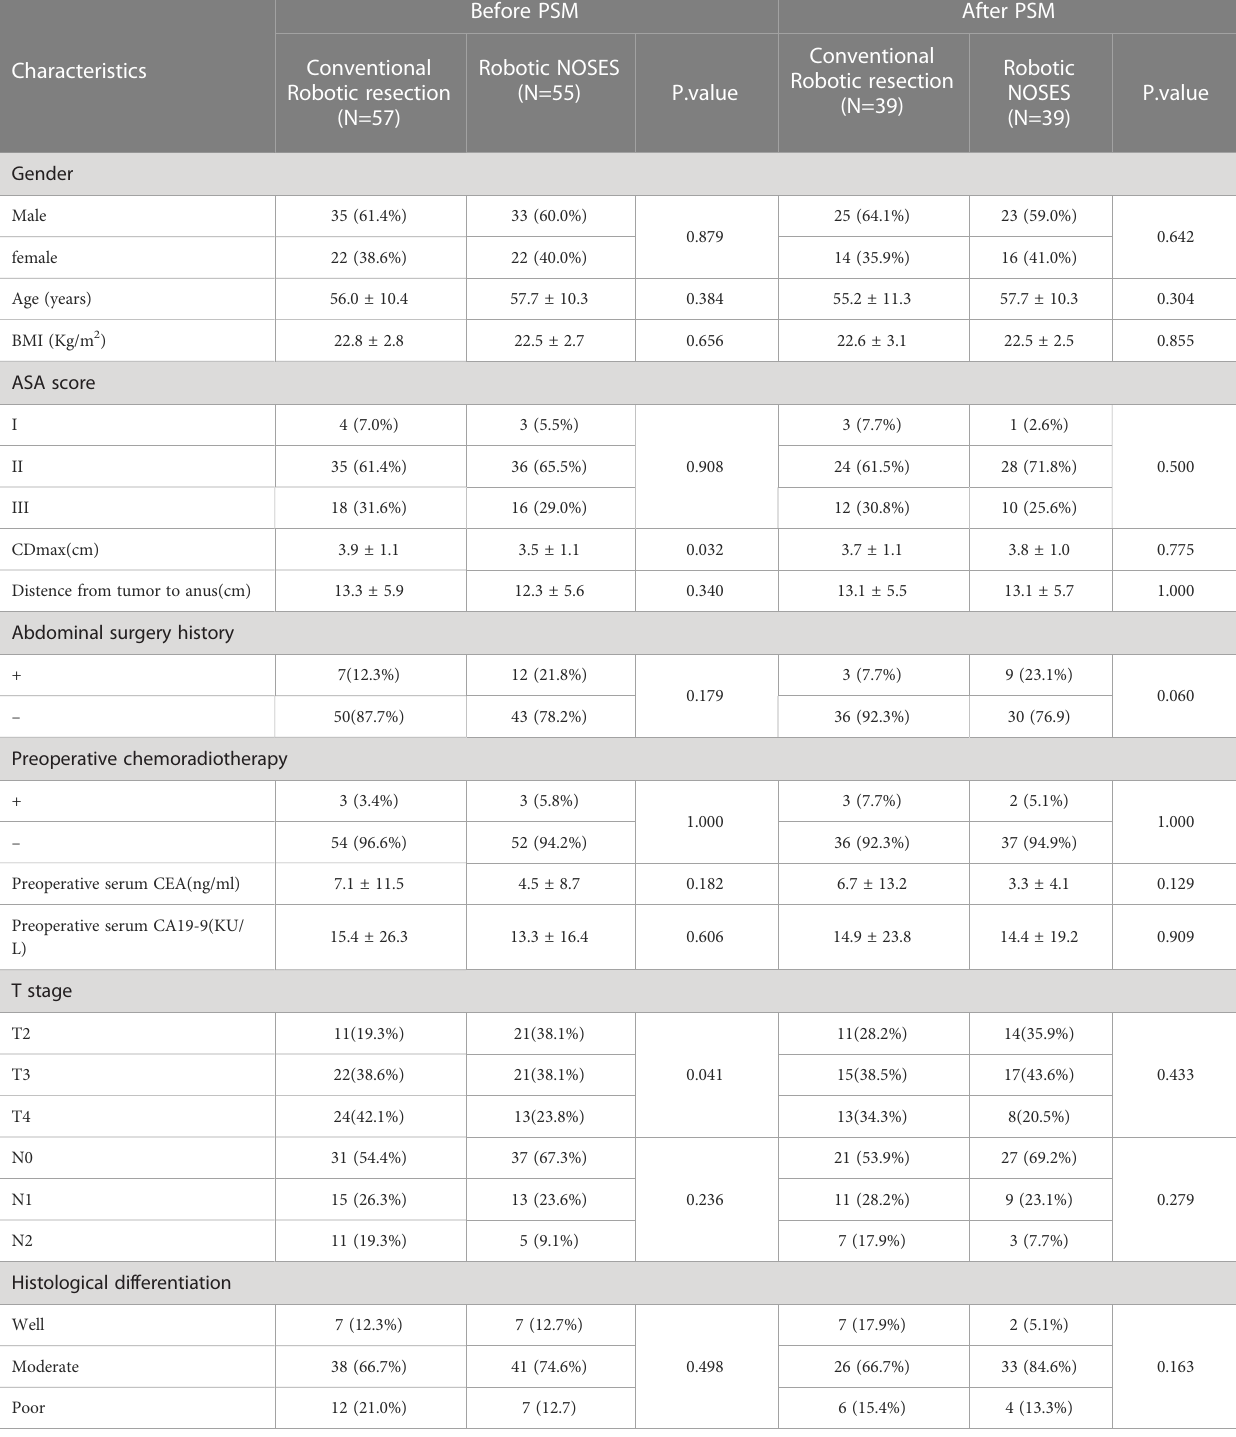
TABLE 1 Clinical characteristics. p<0.05 are indicated in